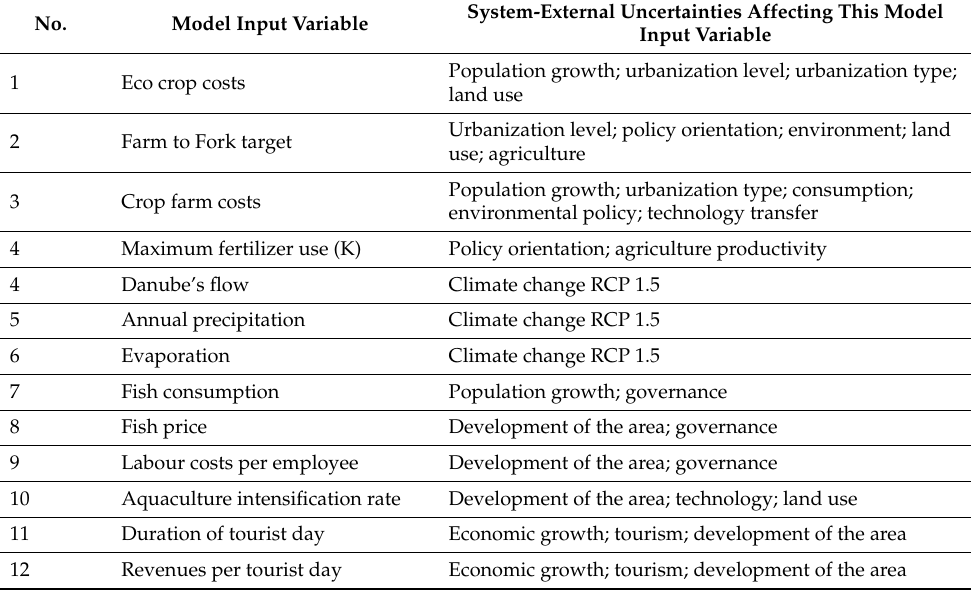
Table 1. Selection of the system dynamics model variables affected by the external uncertainties— Danube